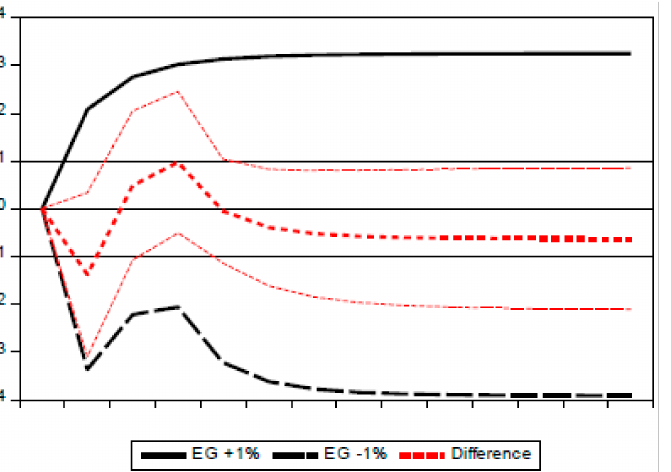
Figure 3. Dynamic multiple adjustments of carbon emission to a unit variation of economic growth in Turkey.